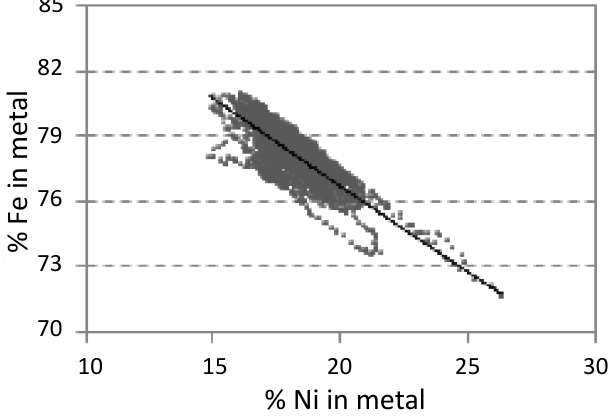
Figure 4. Ni and Fe content in metal ore (Ni/Fe Ratio).